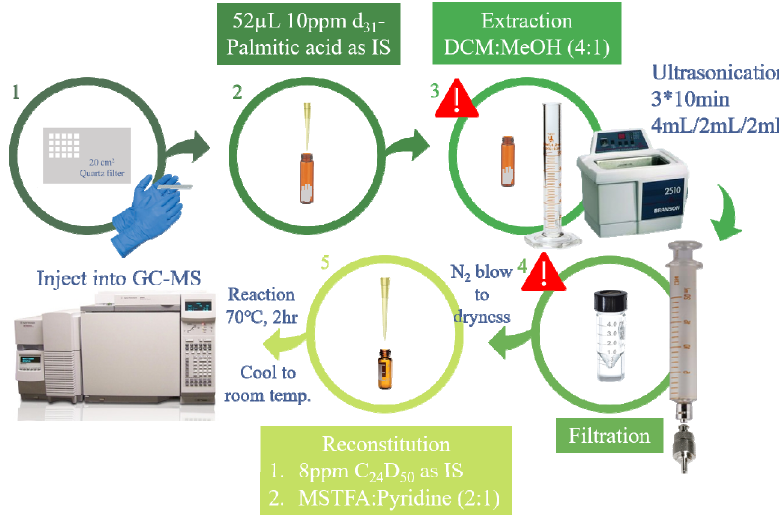
Figure 2. Flowchart of sample pretreatment steps of the revised method.